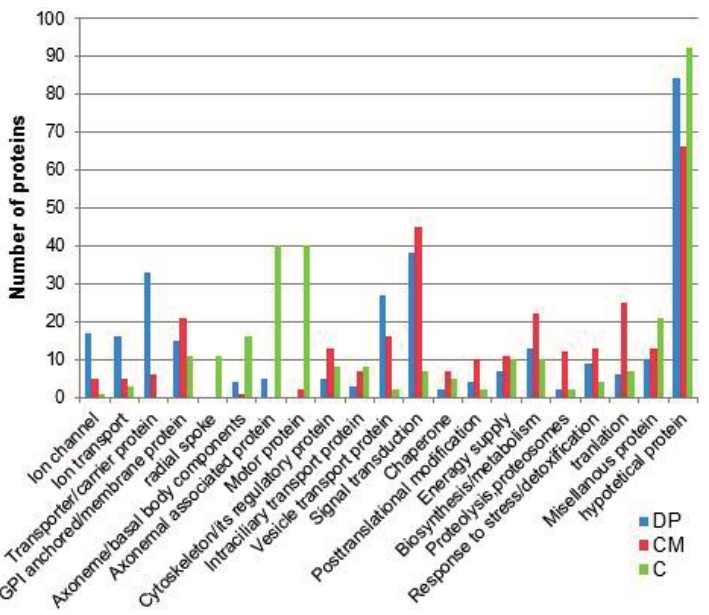
Figure 6. Frequency of proteins organized by function from the 300 most abundant proteins from each preparation: non-fractionated cilia (C), ciliary membrane (CM), and the detergent phase of Triton X-114 phase separation (DP). With permission from Elsevier